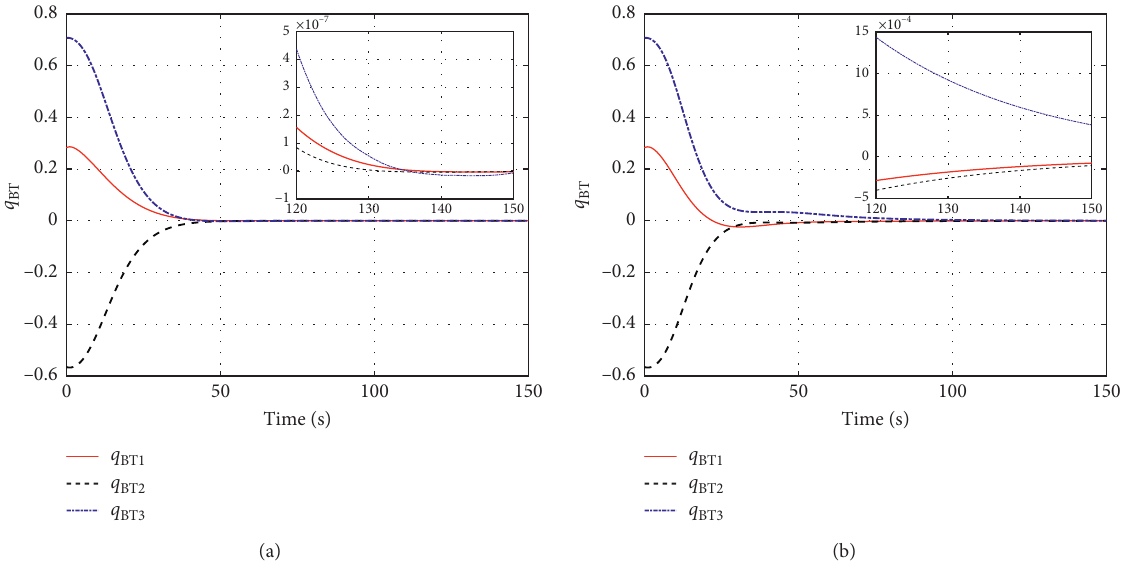
Figure 2: Relative attitude. (a) Proposed I&I adaptive controller. (b) CE-based adaptive